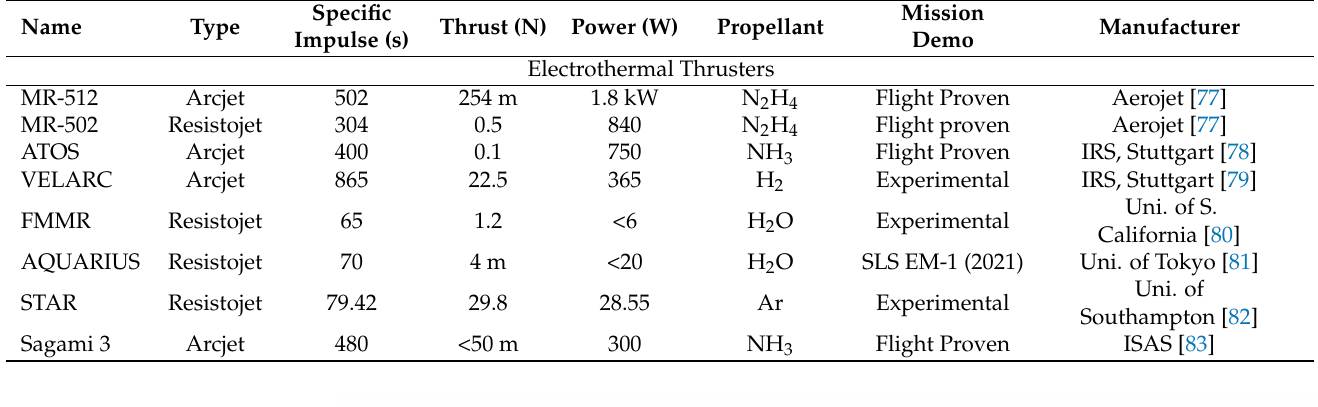
Table 2. Examples of electrothermal thruster parameters.